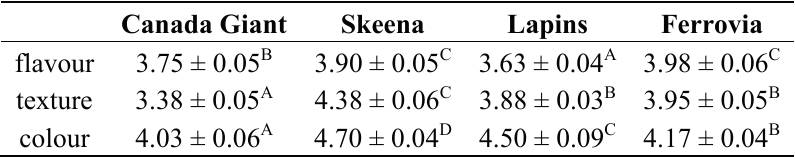
Table 3. Sensory evaluation data for the four cherry